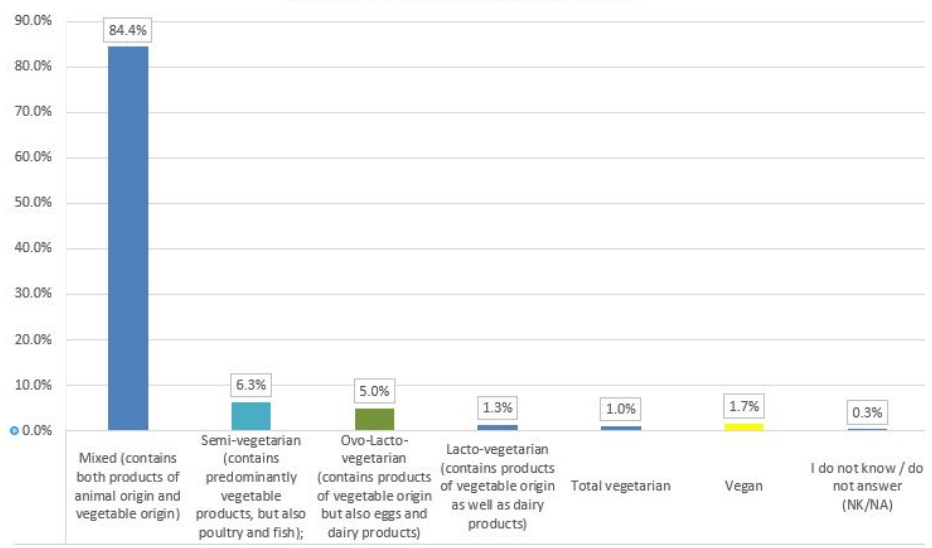
Figure 4. The type of diet reported by participants.